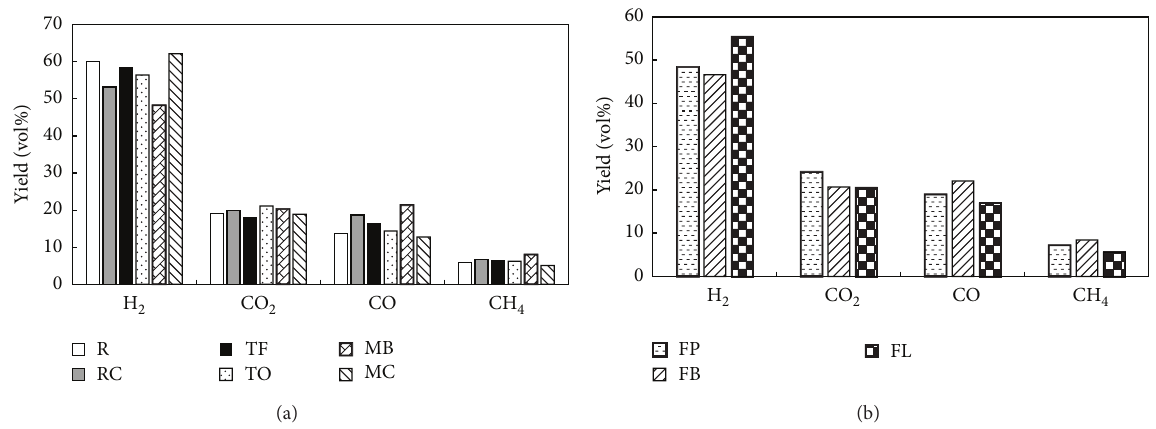
Figure 4: Yields of individual gaseous products from pyrolysis of (a) NHG composts and (b) HG composts at 700 ∘ C and N 2